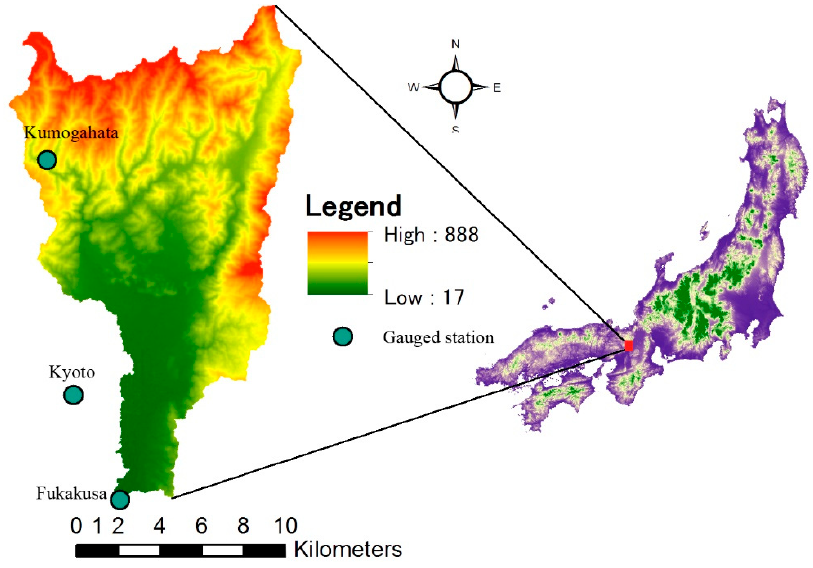
Figure 1. Study area and information of gauged stations.